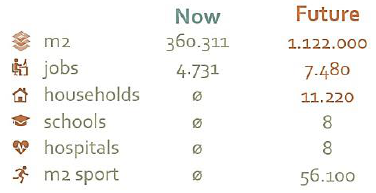
Figure 5. Overview of (some) goals envisioned for Sloterdijk One by year 2040